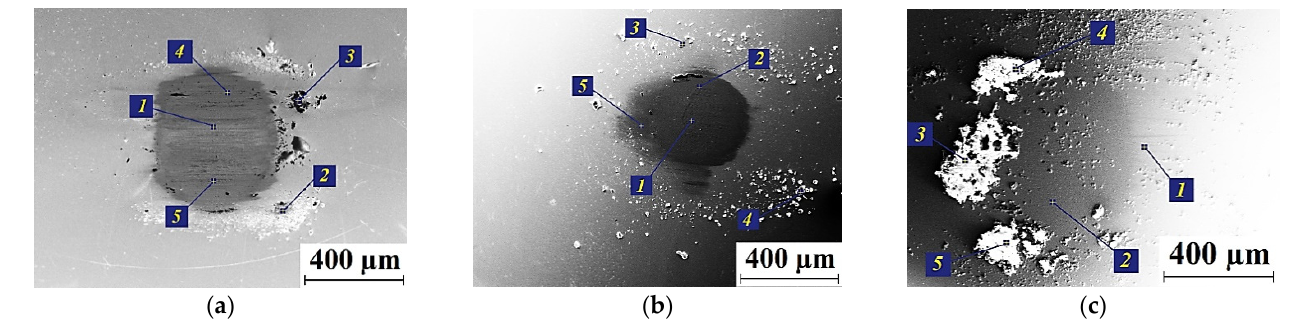
Figure 8. SEM micrographs of the steel counterpart surfaces after the tribological tests: the PI/10CCF/10PTFE ( a ), PI/10CCF/10Gr ( b ), and PI/10CCF/10MoS 2 ( c ) composites. Table 4. The results of EDS analysis of the transfer films and debris on the steel counterpart surfaces in accordance with the labels in Figure 8.